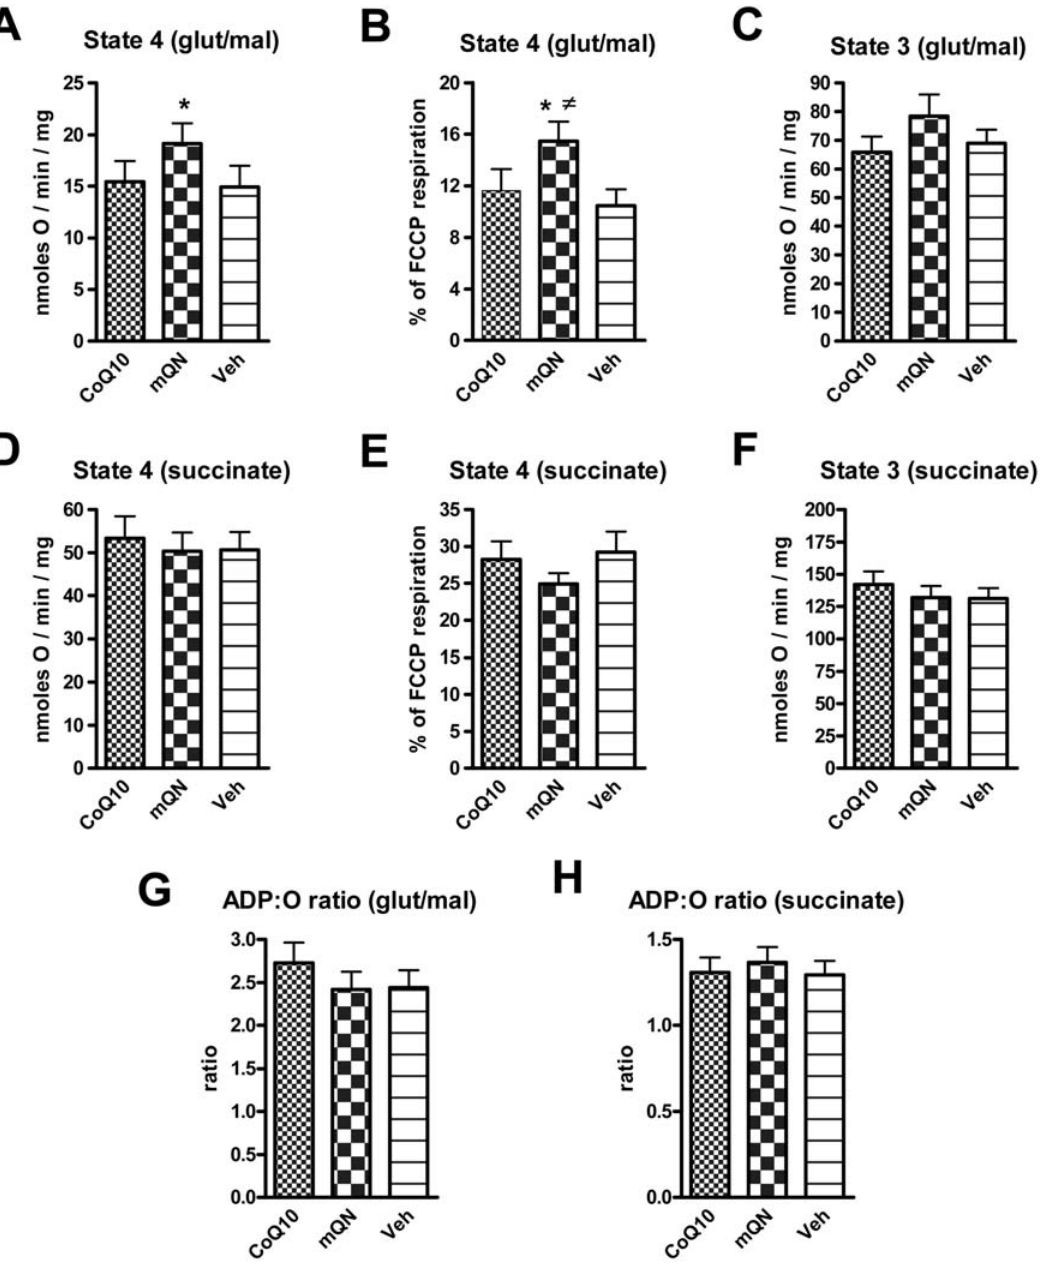
Figure 3. Effect of mitoquinone (mQN) compared to CoQ10 and vehicle on respiration by isolated BAE mitochondria fueled by different substrates. Mitochondria were incubated under state 4 and state 3 conditions fueled by 5 mM glutamate plus 1 mM malate (panels A, B, C) or 5 mM succinate (panels D, E, F). Mitochondria were exposed to 1.0 m M CoQ10, 1.0 m M mitoquinone (mQN), or vehicle (Veh) as indicated. Respiration is expressed in absolute terms (panels A,C,D,E) or as percent of maximal respiration induced by 2.5 m M FCCP (panels B and E). The ADP:O ratio is depicted in panels G and H. Data represent mean 6 SE, * p , 0.05 compared to CoQ10 or vehicle (panel A) or to CoQ10 (panel B), ? p , 0.01 compared to vehicle (panel B) by ANOVA, n=13 for all